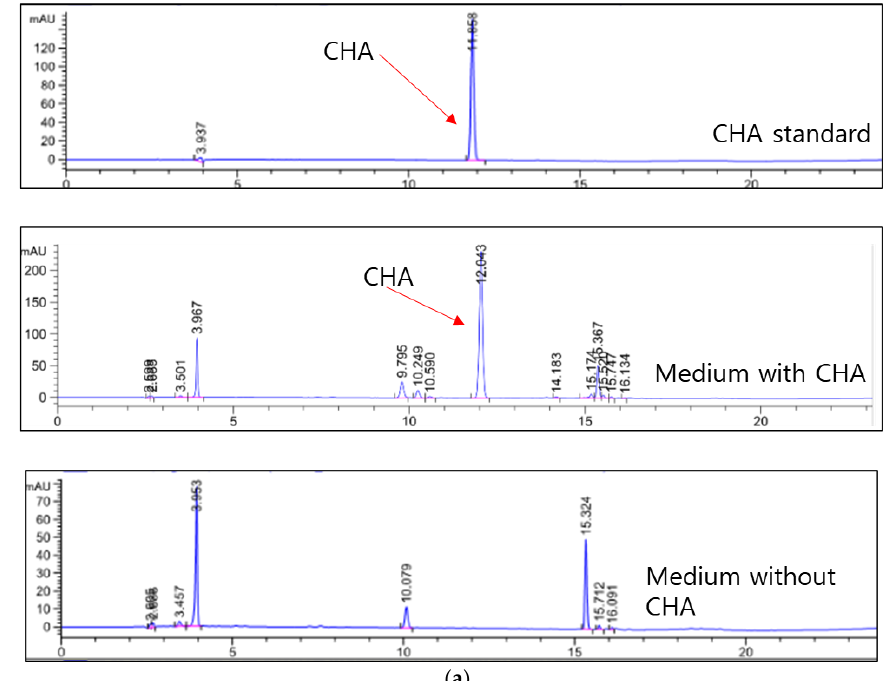
p <0.05 Figure 7. Cont